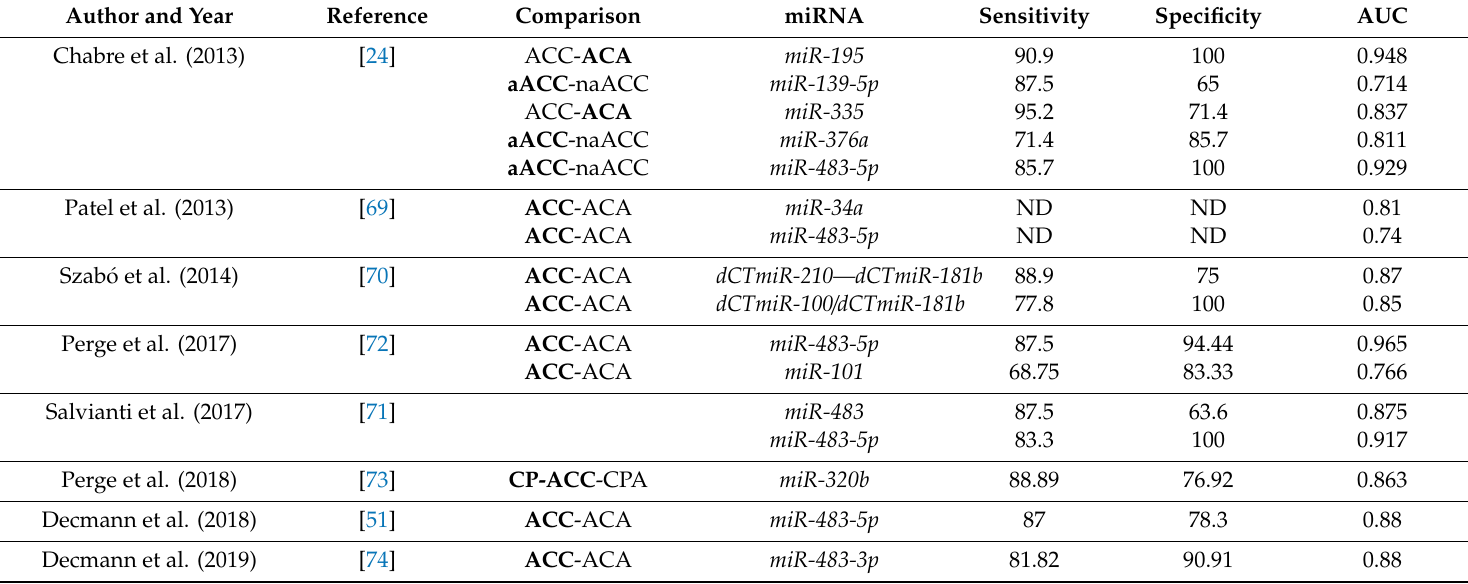
Table 4. Diagnostic applicability of extracellular microRNAs for the di ff erentiation of adrenocortical cancer and adrenocortical